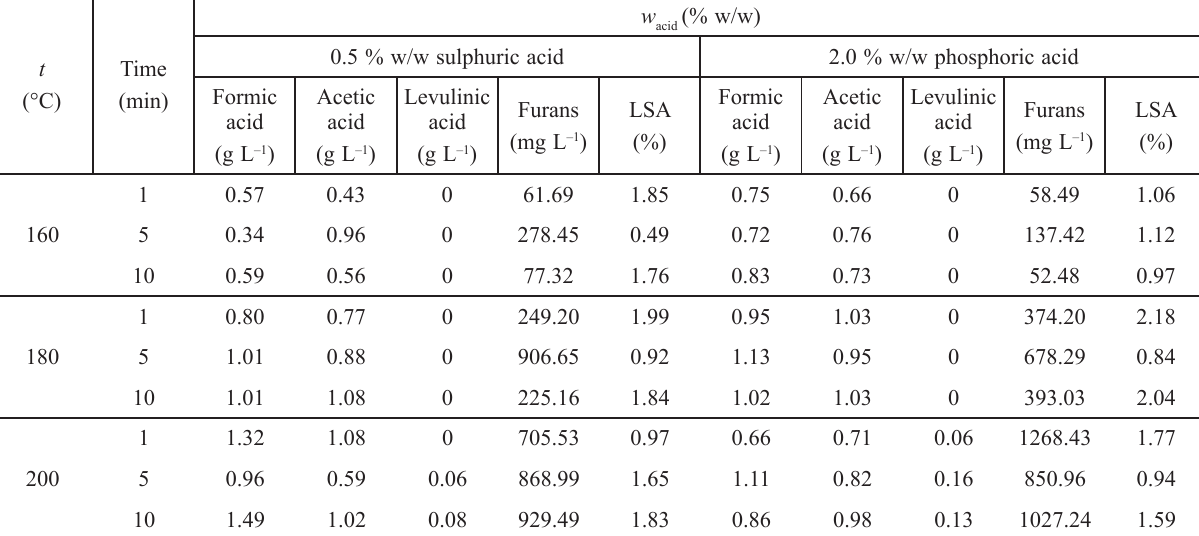
Table 2 – Concentrations of inhibitors in the liquor wheat straw hydrolysates formed during dilute acid pre-treatments in the HPR